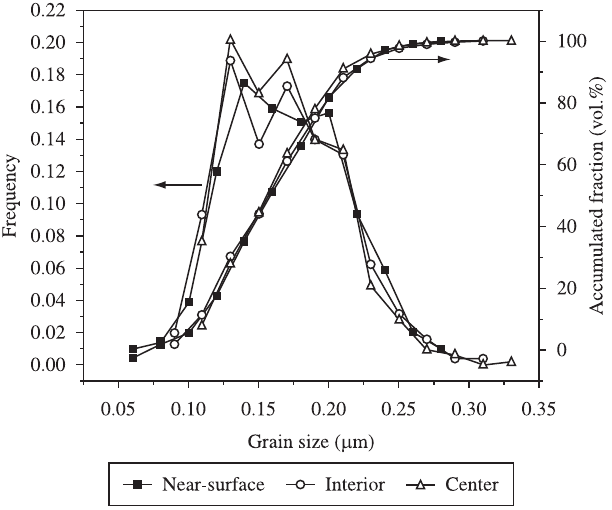
Figure 4. Grain size distribution of the microwave hybrid fast sintered 14.0 g